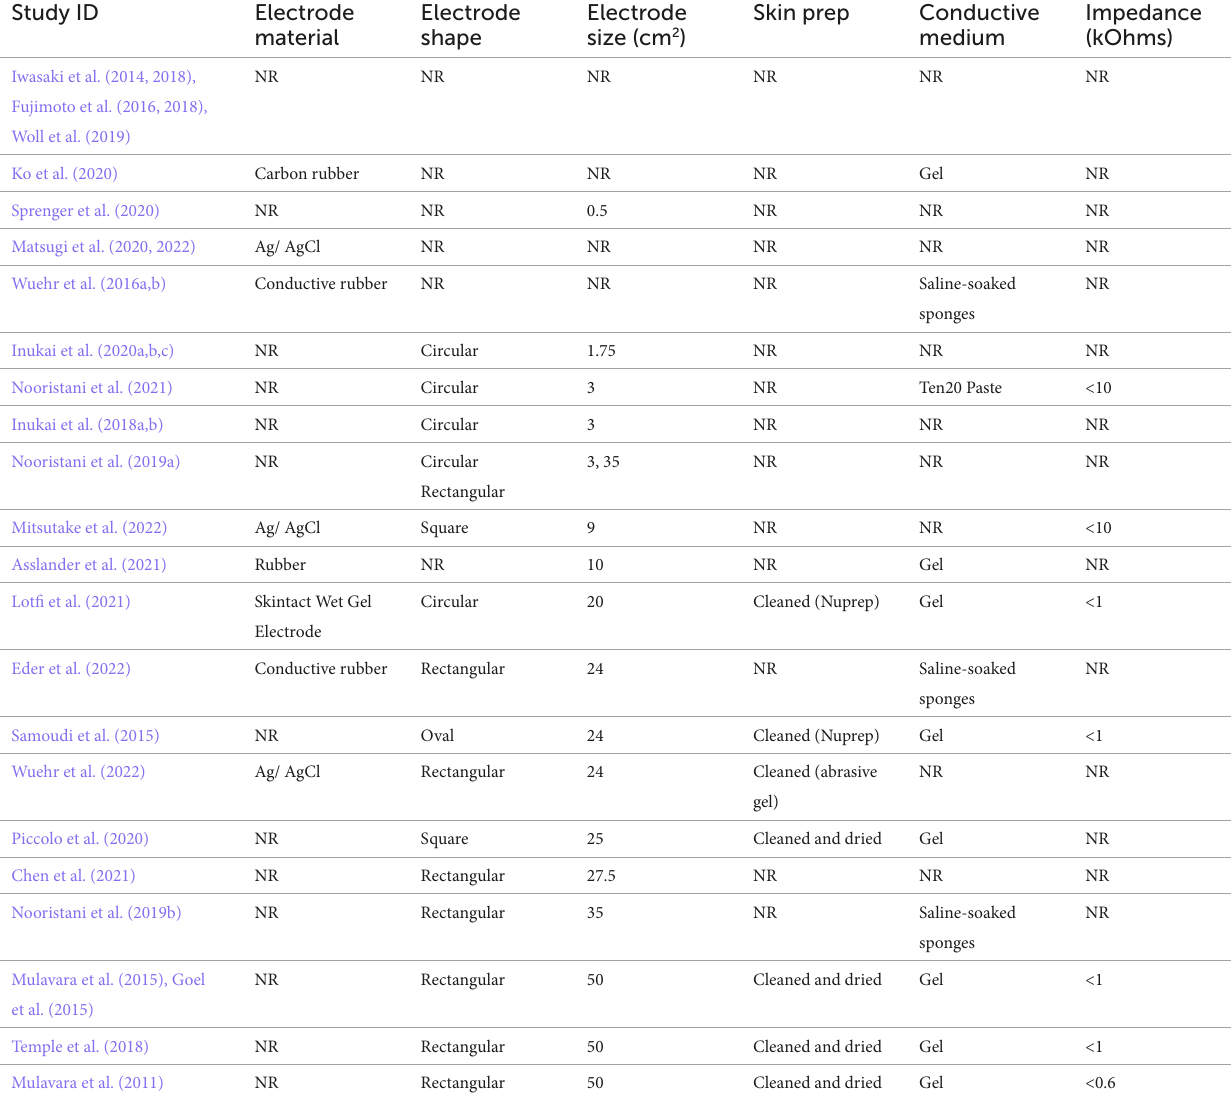
TABLE 3 Summary of electrodes used and the skin electrode